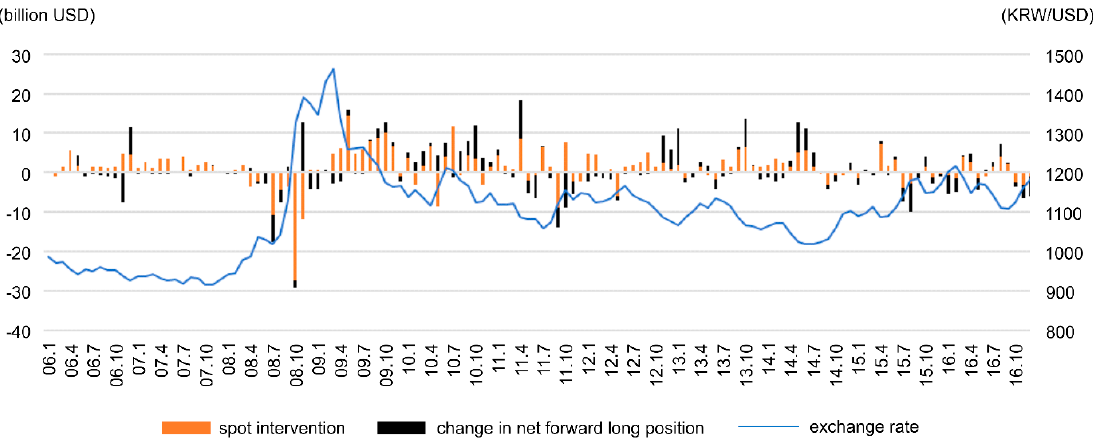
Figure A2. Central bank’s foreign exchange market intervention trends. Note: Change in net forward long position indicates the BOK’s estimated intervention in the forward exchange market. Source: Author’s calculation using International Monetary Fund (IMF) and Bank of Korea (BOK) databases.